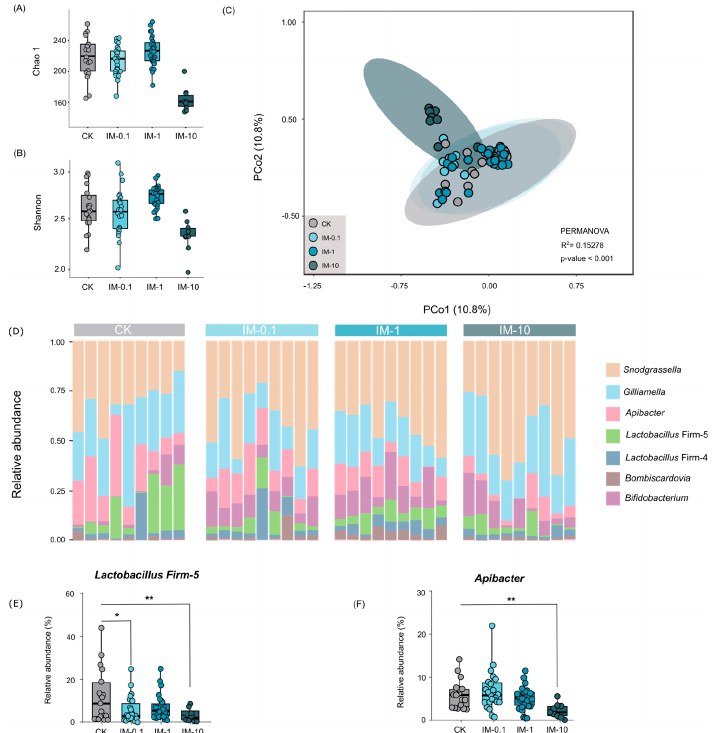
Figure 3. Gut microbiota compositions of the bumblebees under chronic exposure of imidacloprid. ( A ) α -Diversity at genus level estimated by Chao1 richness index. ( B ) Shannon diversity estimator. ( C ) Principal coordinate analysis of gut community composition in control and imidacloprid-treated bumblebees. ( D ) Bar graph of bacterial abundance at the genus level. ( E ) The relative abundance of Lactobacillus Firm-5 in the bumblebee gut. ( F ) The relative abundance of Apibacter in the bumblebee gut. (* p < 0.05, ** p < 0.01) (CK: n = 19, IM-0.1: n = 23, IM-1: n = 28, IM-10: n = 9) CK, IM-0.1, IM-1 and IM-10 represent control, 0.1, 1, and 10 μ g/L imidacloprid treatment.